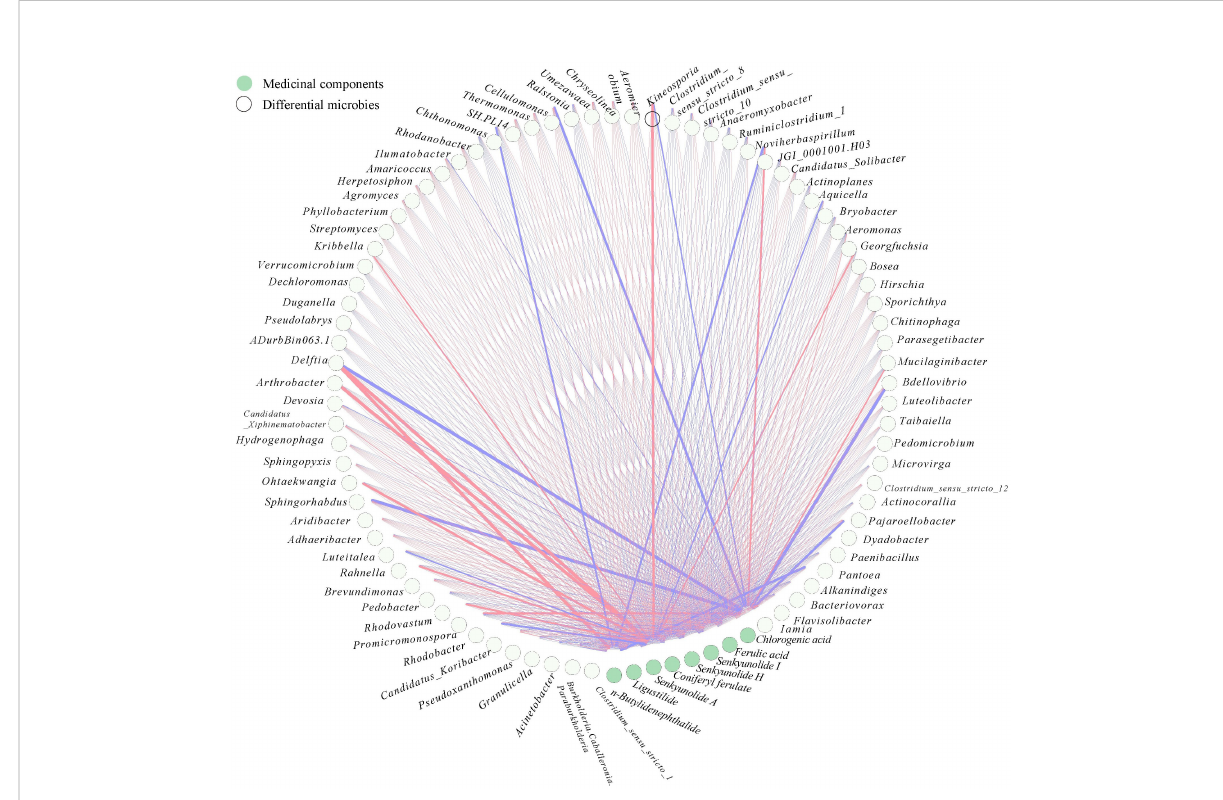
FIGURE 7 Co-occurrence network of the medicinal components and differential microbial taxa in rhizosphere of A. sinensis